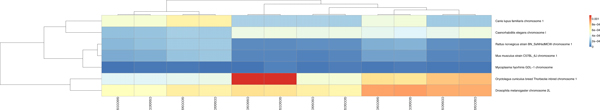
he CCCGGG-spectrum set. This tree is inaccurate because it indicates that the rabbit and the fruit fly are closely related.